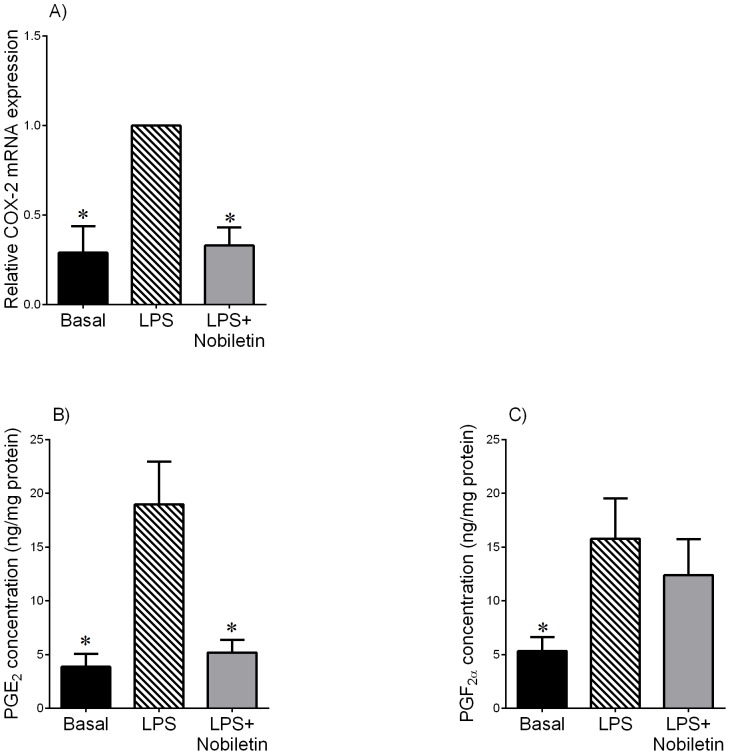
Effect of nobiletin on LPS-induced COX-2 expression and prostaglandin release in term myometrium.Human myometrium was incubated with or without 10 µg/mL of LPS in the absence or presence 200 µM of nobiletin for 20 h (n = 6 patients per group). (A) COX-2 mRNA expression was analysed by qRT-PCR and normalised to GAPDH mRNA expression. The relative fold change was calculated relative to LPS and data presented as mean ± SEM. *P<0.05 vs. LPS (one-way ANOVA). (B,C) The incubation medium was assayed for concentration of PGE2 and PGF2α by enzyme immunoassay. Each bar represents mean concentration ± SEM. *P<0.05 vs. LPS (one-way ANOVA).